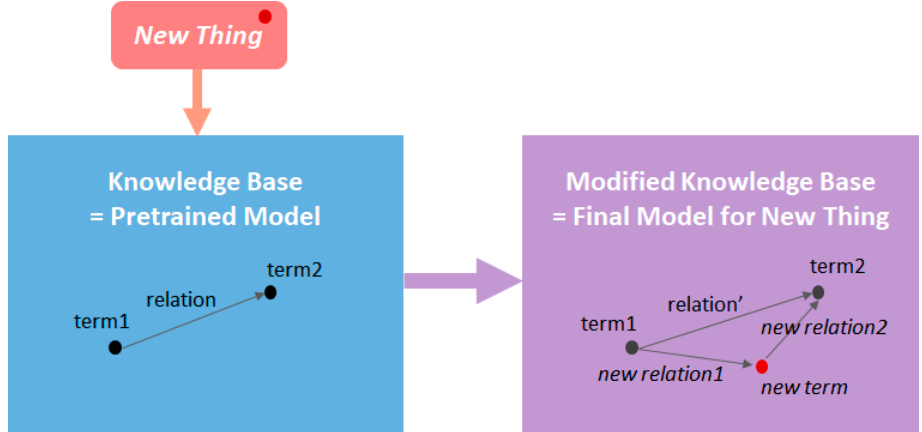
Figure 1. Conceptual diagram of research design.